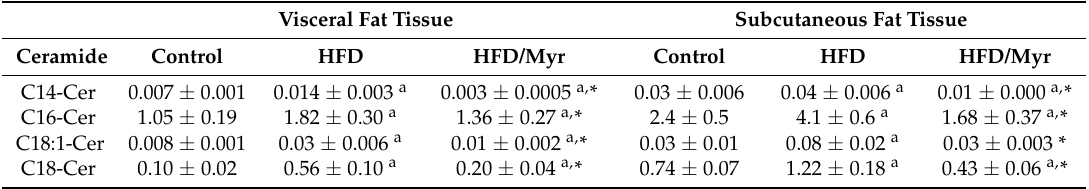
total DAG content in two depots of adipose tissue. White bars—control group; grey bars—HFD group; black bars—HFD/Myr group. Values are mean +/ − SD. Symbols denote statistical significance of p < 0.05 versus: a —vs. control group; *—vs. HFD group. Table 3. Ceramide in two depots of adipose tissue. Values are mean (pmol/mg tissue) +/ −